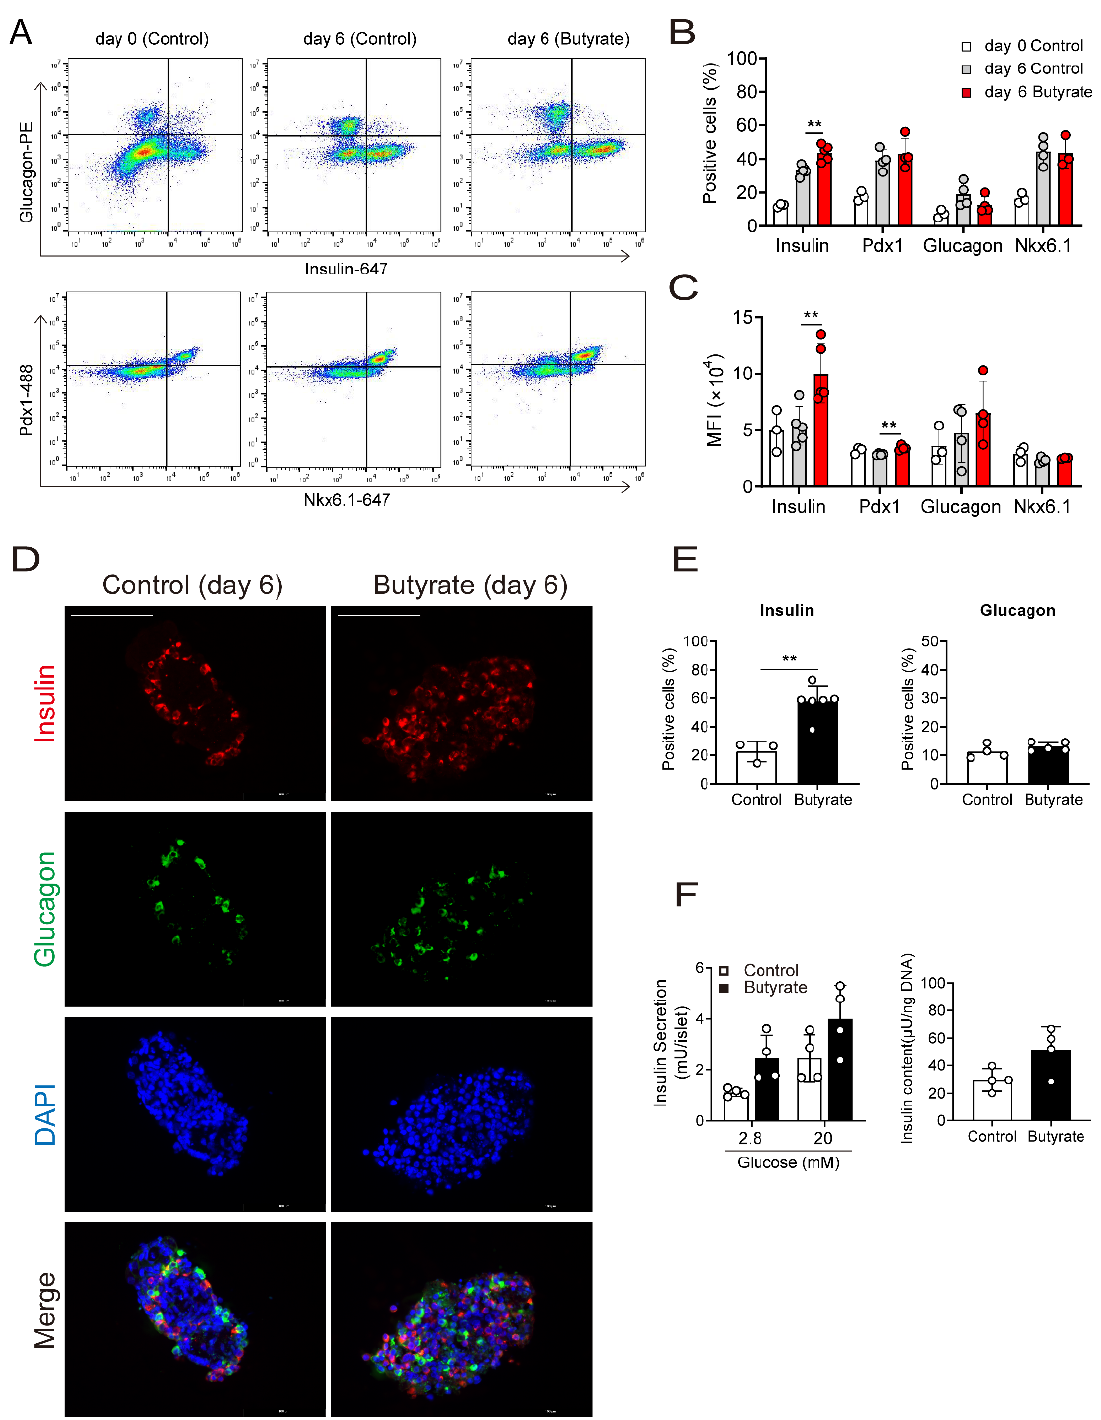
Figure 2. Butyrate increased the number of insulin positive cells and insulin content. ( A ) FACS analysis of NPICCs before and after treatment with butyrate (1000 µM) for six days. NPICCs were dispersed into single cells and analyzed by intracytoplasmic staining for insulin (AF647), glucagon (PE), Pdx1 (AF488) and Nkx6.1 (AF647). ( B and C ) Butyrate increased the number of insulin positive cells and the median fluorescence intensity (MFI) of insulin stained cells. ( D and E ) Immunofluorescence staining for insulin (red) and glucagon (green) confirmed increase of insulin positive NPICCs in the butyrate treated group (1000 µM for six days). scale bars = 100 µm. ( F ) GSIS and Insulin content were moderately increased in NPICCs treated with butyrate. Data are presented as mean ± SD ( B, E, F ) or median ± SD ( C ) of three to six independent experiments. ** p < 0.01 vs. control group.